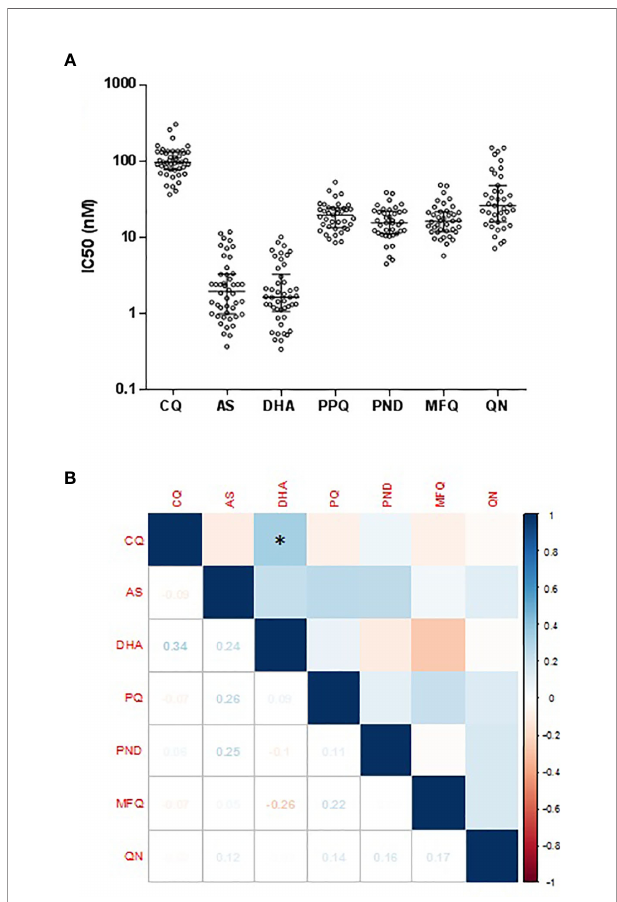
FIGURE 1 | IC50 values of each antimalarial drug among P. vivax isolates P. vivax isolates for each antimalarial drug. (A) Dot plots of ex vivo susceptibilities of P. vivax isolates to seven antimalarial drugs. Comparison of ex vivo IC 50 values (in nM) to seven antimalarial drugs. (B) Correlations between IC 50 s of P. vivax isolates to seven antimalarial drugs. Used Spearman ’ s test to analyze the correlation between IC 50 s Spearman ’ s correlation analysis between IC 50 values of parasite isolates to seven antimalarial drugs. The values of correlation coef fi cient based on the right side of the color scale. The values of the correlation coef fi cient were based on the color scale shown on the right. *indicates a signi fi cant